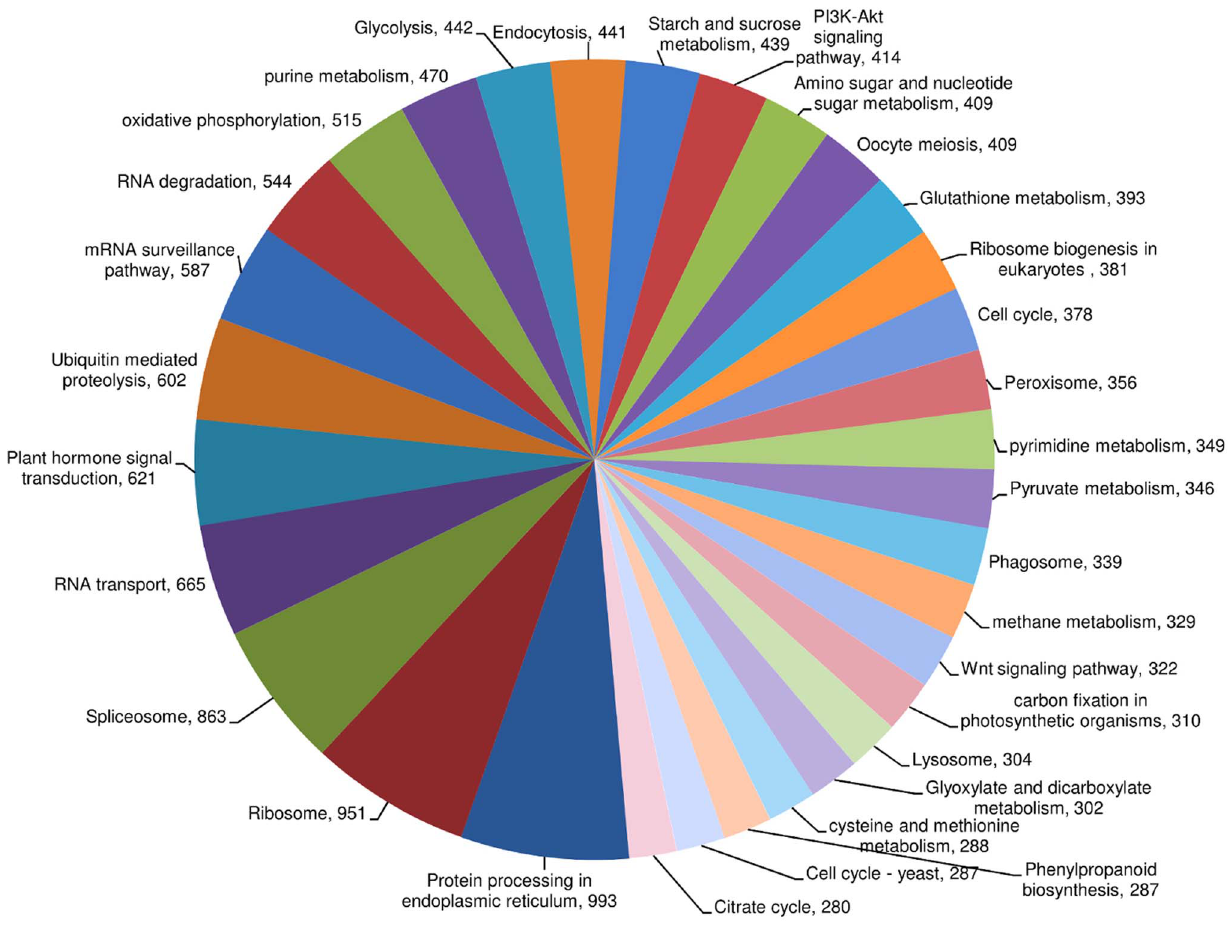
Figure 4. Distribution of transcript contigs to different biological pathways. Values indicate number of transcript contig representation in each pathway. Pathways with number of transcript contigs below 280 are not shown in the chart.